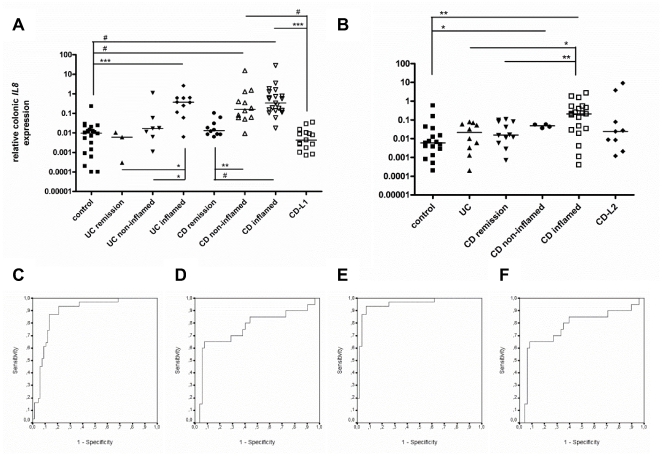
Correlation of endoscopic inflammation and transcriptional expression of IL8.
IL8 mRNA expression determined in A. colonic and B. ileal mucosal samples is increased in biopsies taken in inflamed areas of inflammatory bowel disease (IBD) patients when compared to healthy controls. In samples of patients in remission, colonic samples of Crohn's disease (CD) patients with isolated ileal disease (CD-L1) and ileal samples of CD patients with isolated colonic disease (CD-L2), IL8 levels are similar to healthy controls. Whereas no increase in IL8 is observed in samples taken in endoscopically non-inflamed mucosa of active ulcerative colitis (UC) patients, a significant increase is seen in non-inflamed colonic samples of active CD patients when compared to healthy controls. The data are expressed as medians and presented on a log scale (*p<0.05, **p<0.01, ***P<0.001, #P<0.0001). A ROC curve analysis of IL8 was performed on all samples (C. colon and D. ileum) and when non-inflamed samples of active CD patients were excluded (E. colon and F. ileum). The increase in sensitivity when excluding non-inflamed colonic samples of active CD patients confirms that those samples are an inappropriate control for the study of inflammation.